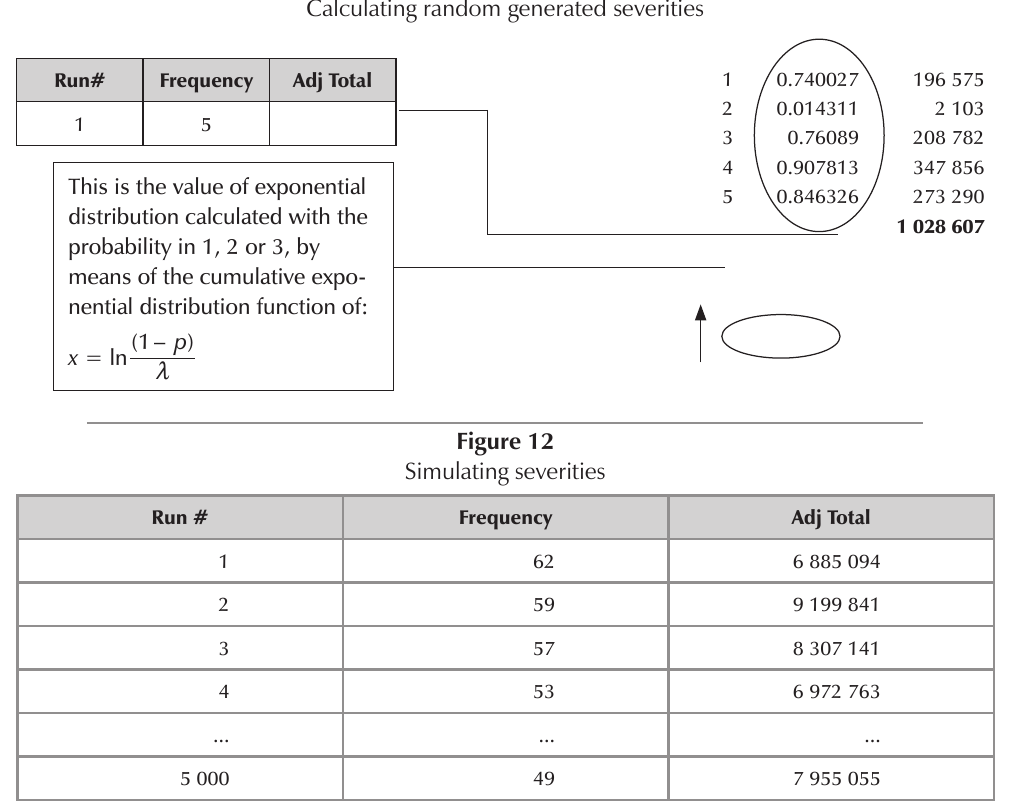
Calculating random generated severities